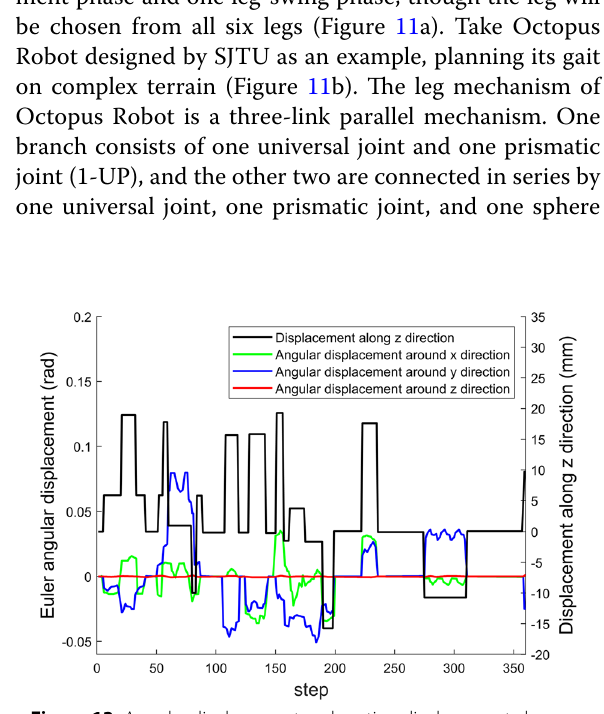
Figure 13 Angular displacement and motion displacement along z direction of Octopus